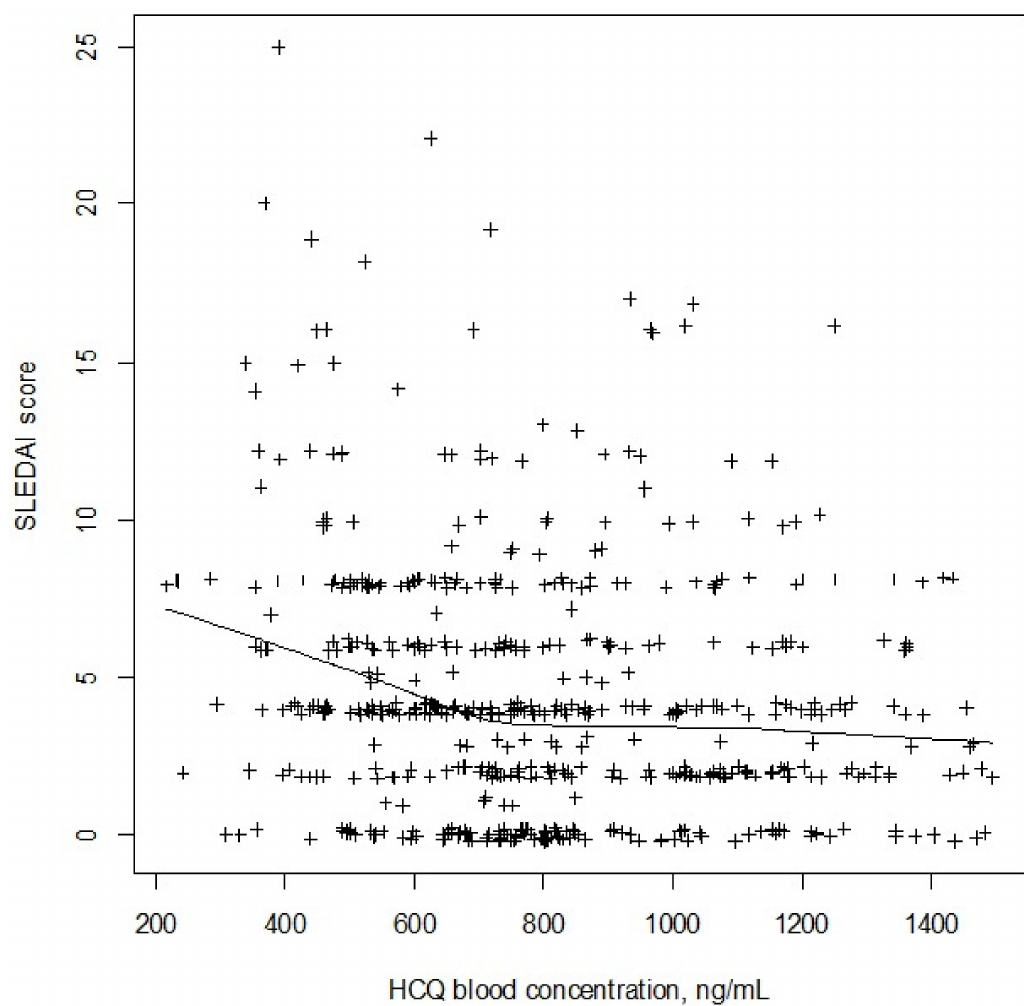
Figure 3. SLEDAI scores as a function of blood HCQ concentrations. The black curve is drawn after a spline function and shows the trend.